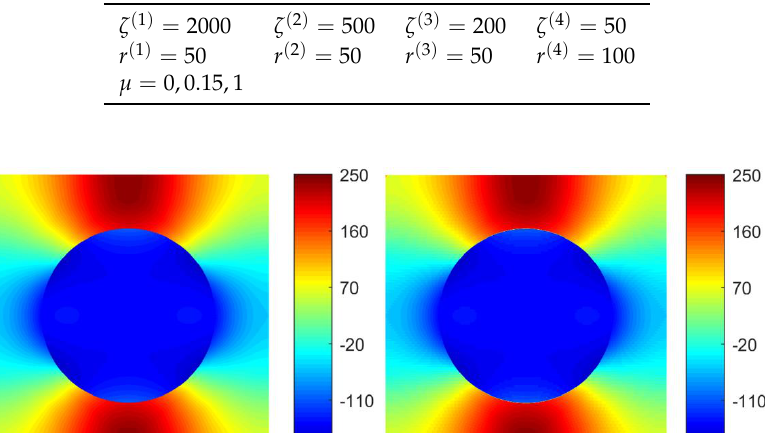
Table 2. Kinematic hardening parameters.